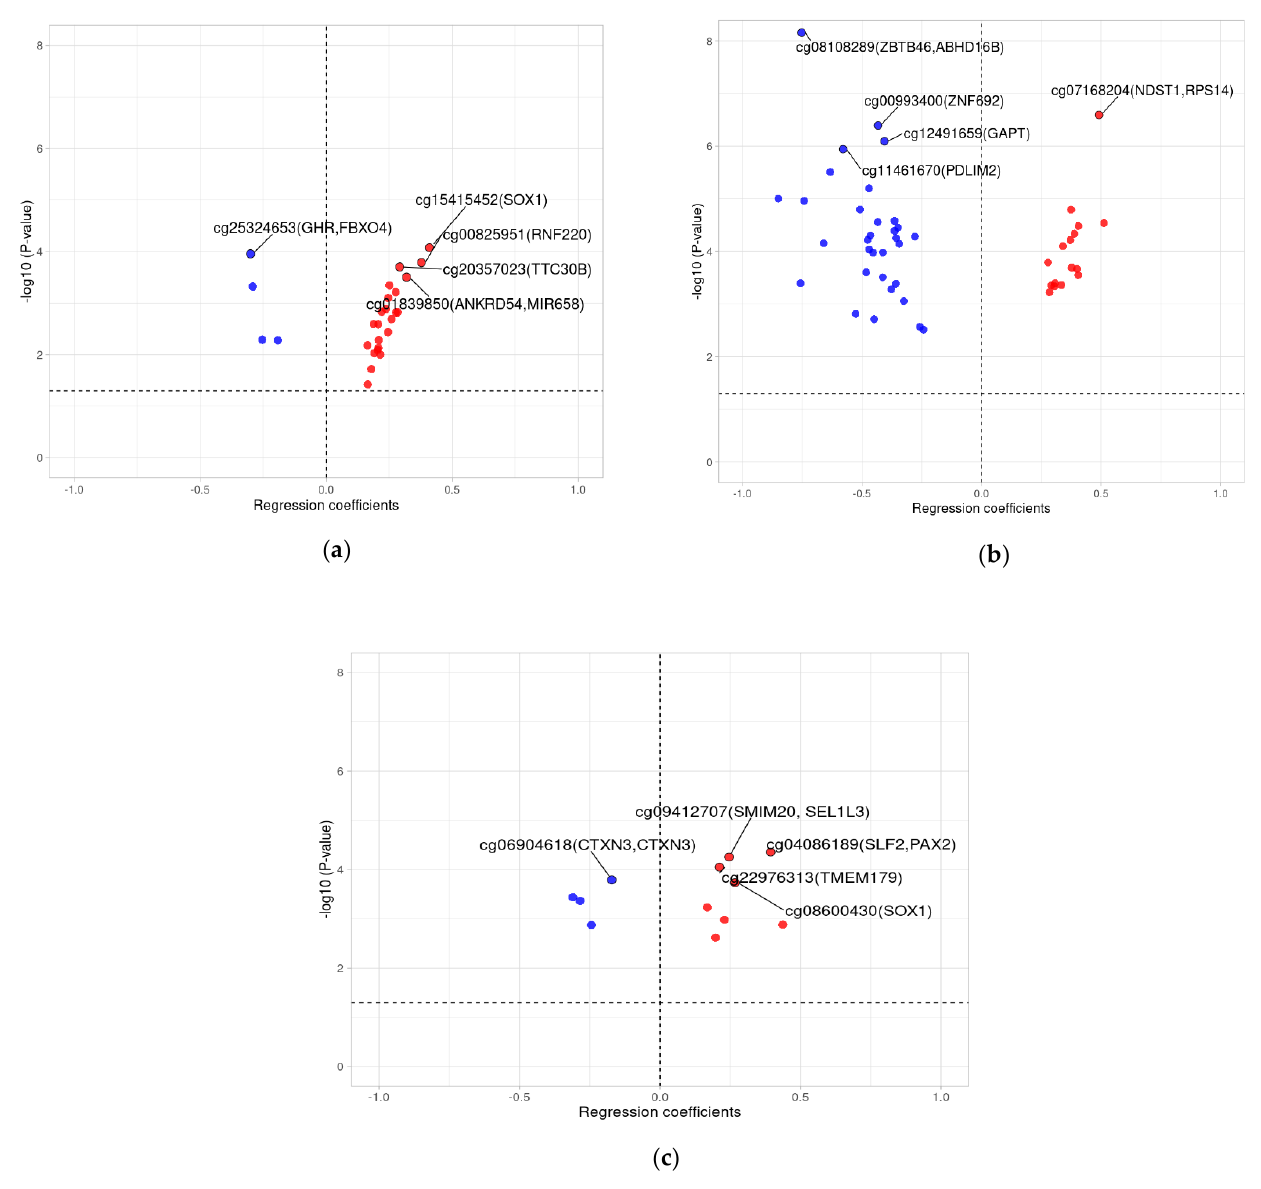
Figure 4. Volcano plots of − log10 ( p -value) against regression coefficients of each infant feeding mode after adjusting for the confounders. The lower part of the volcano plot is not shown. The x-axis represents change of DNAm from birth to 10 years and the y-axis is − log10 transformed raw p -values ( − log10p). The red-color dots denote positive regression coefficients and are towards the right side, and the blue-color dots represent negative coefficients are towards the left side of the plots. The horizontal dashed line indicates cutoffs for significance of raw p < 0.05, vertical dashed lines indicate regression coefficient cutoff of zero. ( a ) Volcano plot showing a total of 27 CpG sites methylated in the exclusive breastfeeding group with p < 0.05. ( b ) Volcano plot showing a total of 48 CpG sites methylated in the exclusive formula feeding group with p < 0.05. ( c ) Volcano plot showing a total of 12 CpG sites methylated in mixed feeding group with p < 0.05.